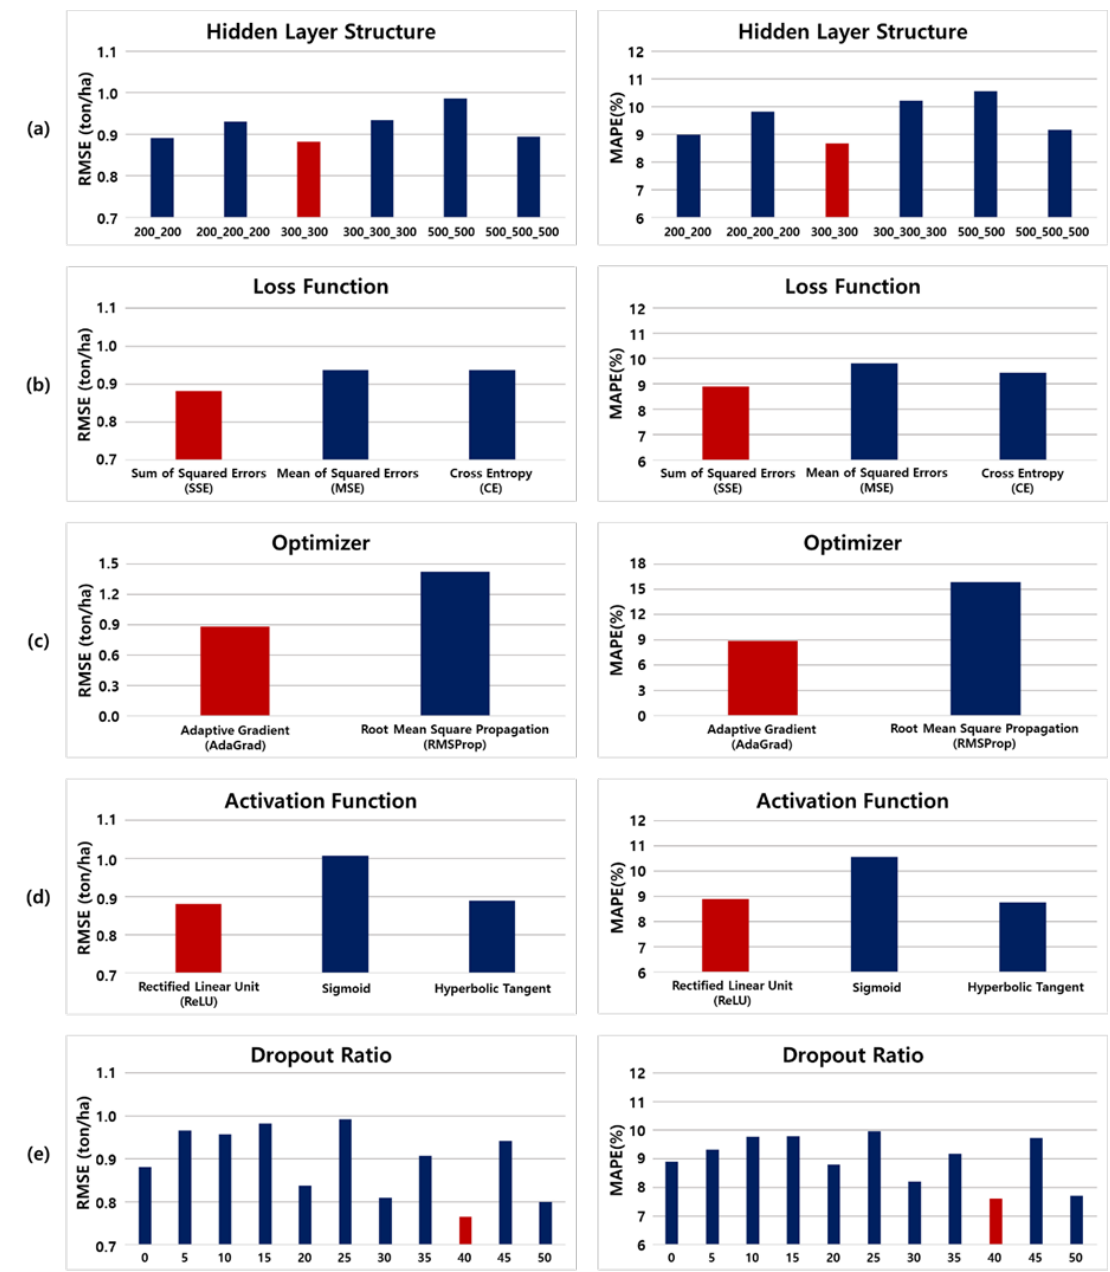
Figure 4. The results of the optimized deep neural network (DNN) model: root mean square error (RMSE) and mean absolute percentage error (MAPE) according to the ( a ) hidden layer structure, ( b ) loss function, ( c ) optimizer, ( d ) activation function, and ( e ) drop-out ratio.